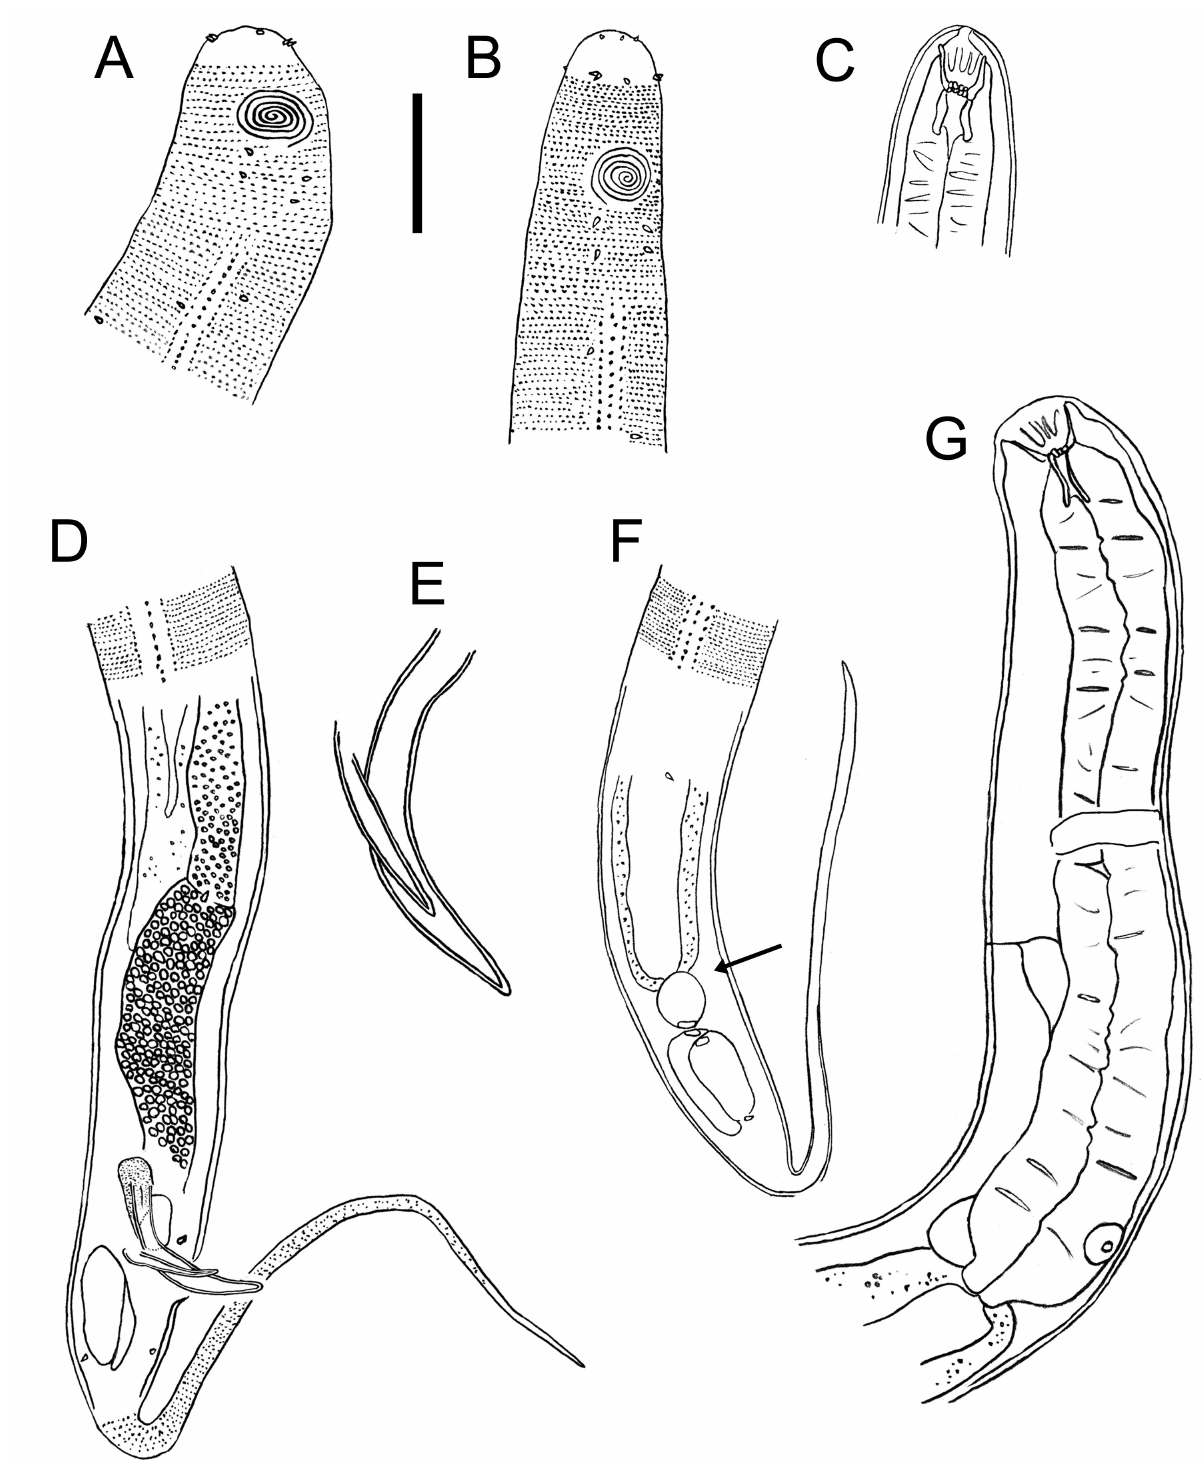
Fig. 14. Bendiella thalassa gen. et sp. nov. A . Surface view of male head. B . Surface view of female head. C . Female head, showing buccal cavity. D . Posterior body region of male. E . Spicule and gubernaculum. F . Posterior body region of female. G . Anterior body region of male. Arrow shows position of lateral hypodermal gland near posterior end of intestine. Scale bar: A-C, G = 25 µ m; D, F = 32 µ m; E = 13